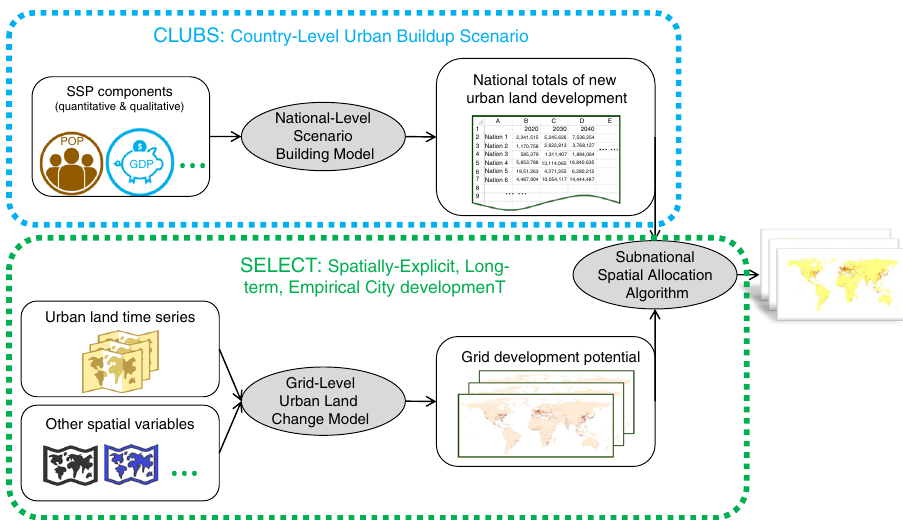
Fig. 6 Modeling framework. This framework consists of two new data-driven urban simulation models: The Country-Level Urban Buildup Scenario (CLUBS) model estimates national total amounts of new urban land development under various socioeconomic scenarios. The Spatially-Explicit, Long-term, Empirical City developmenT (SELECT) model allocates the national totals, fi rst to subnational regions, and then to 1/8° grid cells according to their estimated development potentials. Both models evolve over time decade by decade. (Gray ovals — model parts; white squares — input data and intermediate